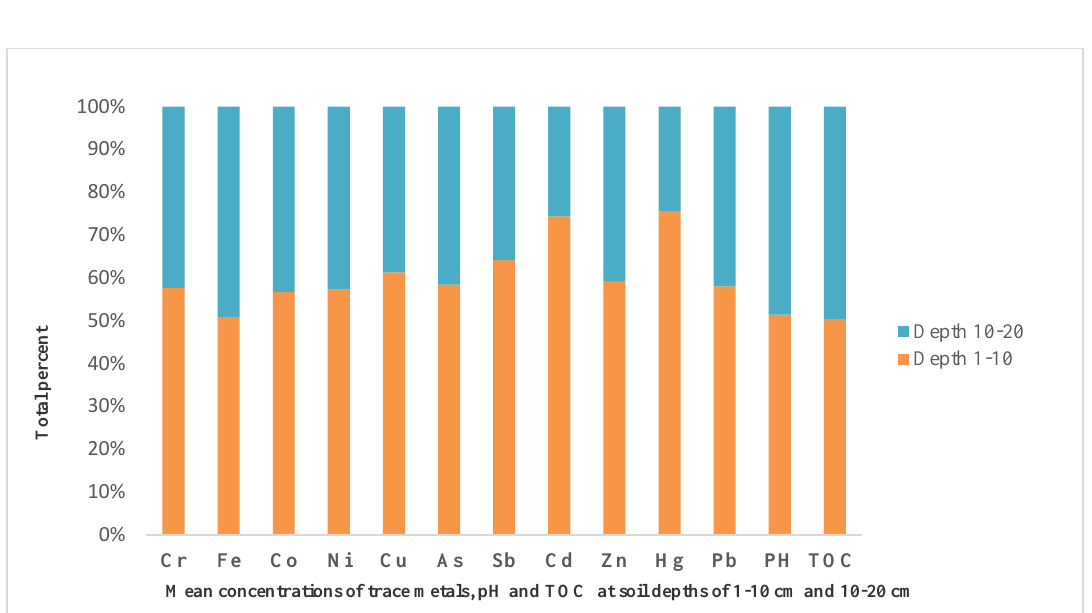
Figure 2. The mean concentrations of trace elements and selected soil properties (pH and TOC) at soil depth of (1 – 10 and 10 – 20 cm).